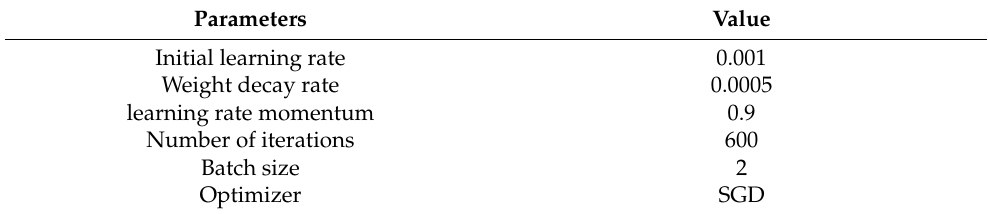
Table 5. Initialization